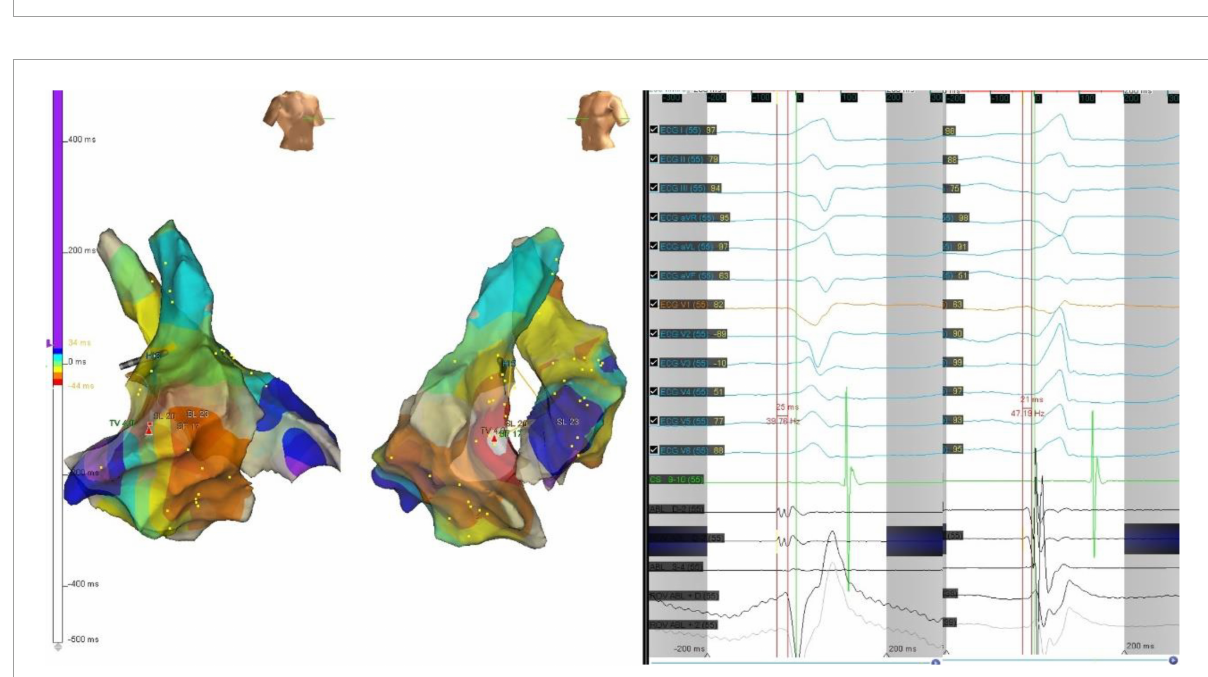
FIGURE5 The precordial R wave transition occurred at V3 in ECG (left) before first ablation. Electroanatomic mapping in the right ventricle and the left ventricle, the earliest activation site was located at right basal septum with a preceding time compared with the onset of the QRS wave of 25 ms. After initial ablation failed, the precordial R wave transition occurred at V2 in ECG (right) . Remapping at the bilateral side of the basal septum was performed. The earliest activation site was located at left basal septum with a preceding time compared with the onset of the QRS wave of 21 ms. The PVC was successfully eliminated by ablation of both sides of basal septum.